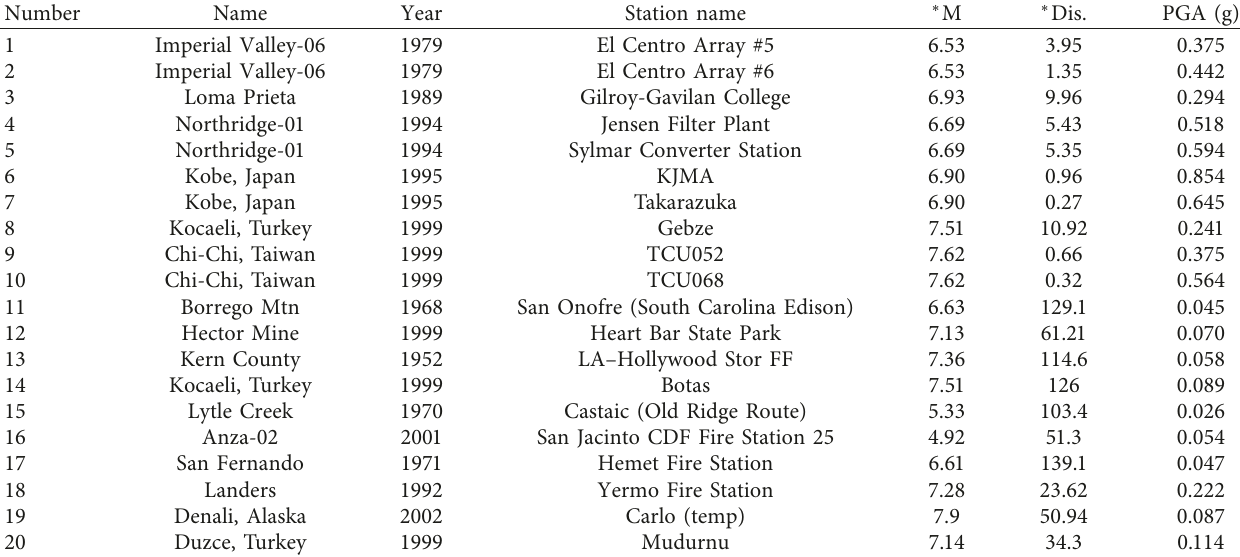
Table 3: Selected earthquake ground motions.